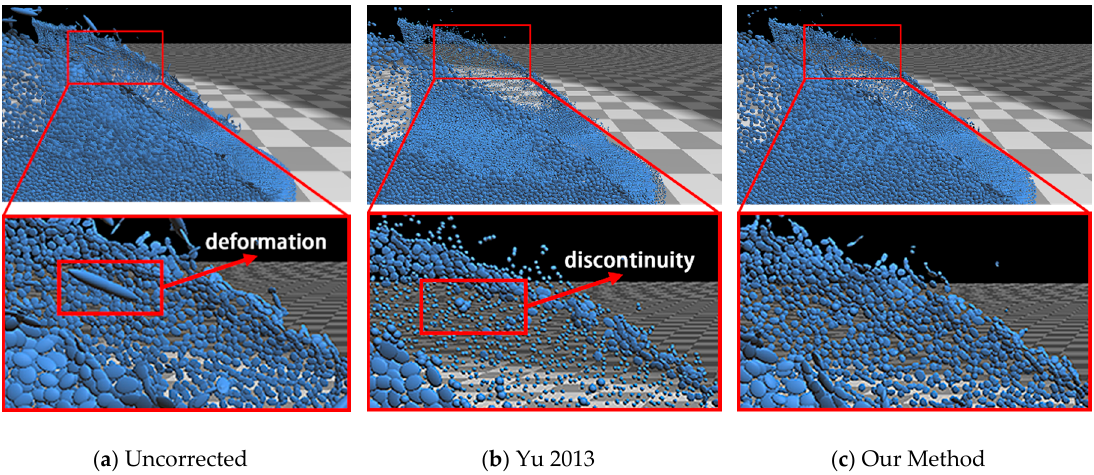
Figure 14. ( a ) The rendering effect of uncorrected anisotropic particles, many of which are deformed; and ( b ) the deformed particles corrected by the Yu 2013 method. Although there are no deformed particles, many isotropic particles exist. ( c ) The deformed particles in ( a ) corrected by the presented method. It can be seen that the anisotropy is well maintained and the deformed particles are effectively removed.